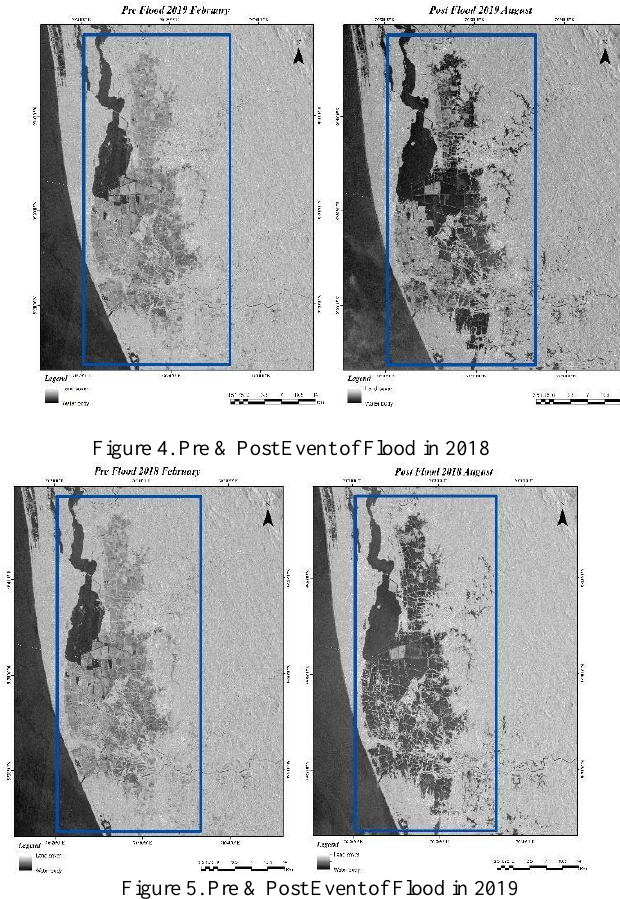
Table 1. Data Type & Data Acquisition